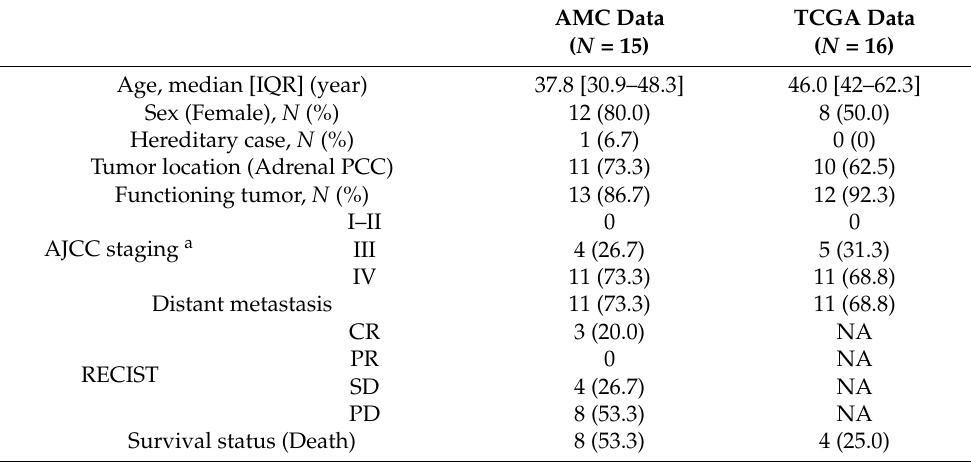
Table 1. Baseline